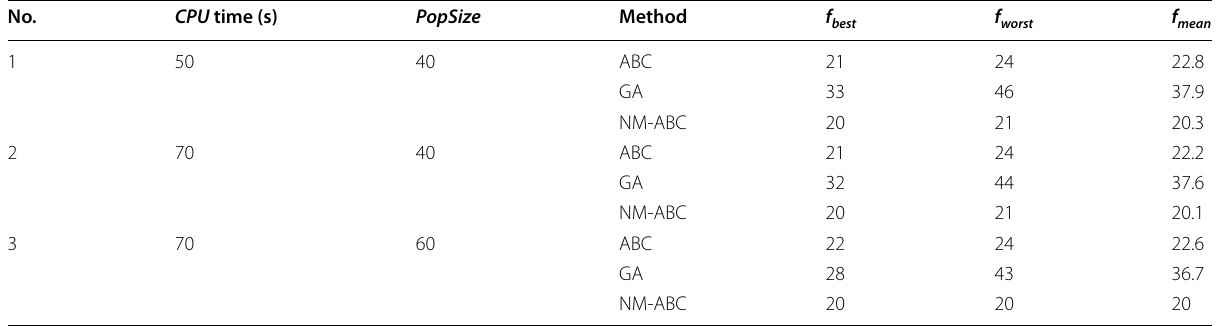
Table 8 Result comparison of the three algorithms for case study 2 No.